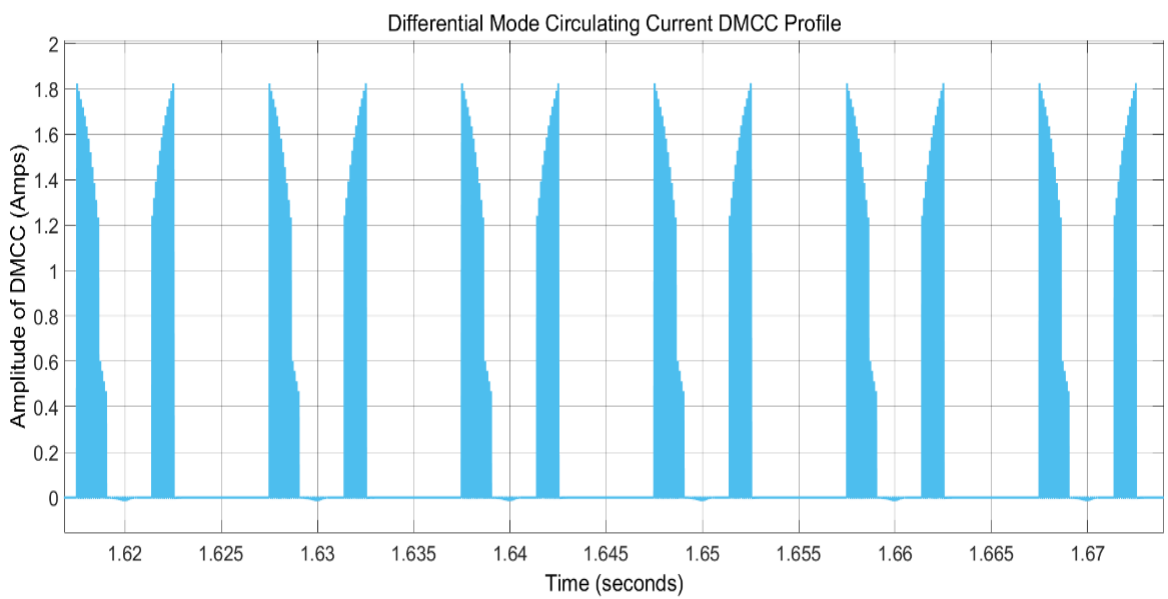
Figure 17. Inductor current w.r.t. gate pulses in converter DCM mode of operation.